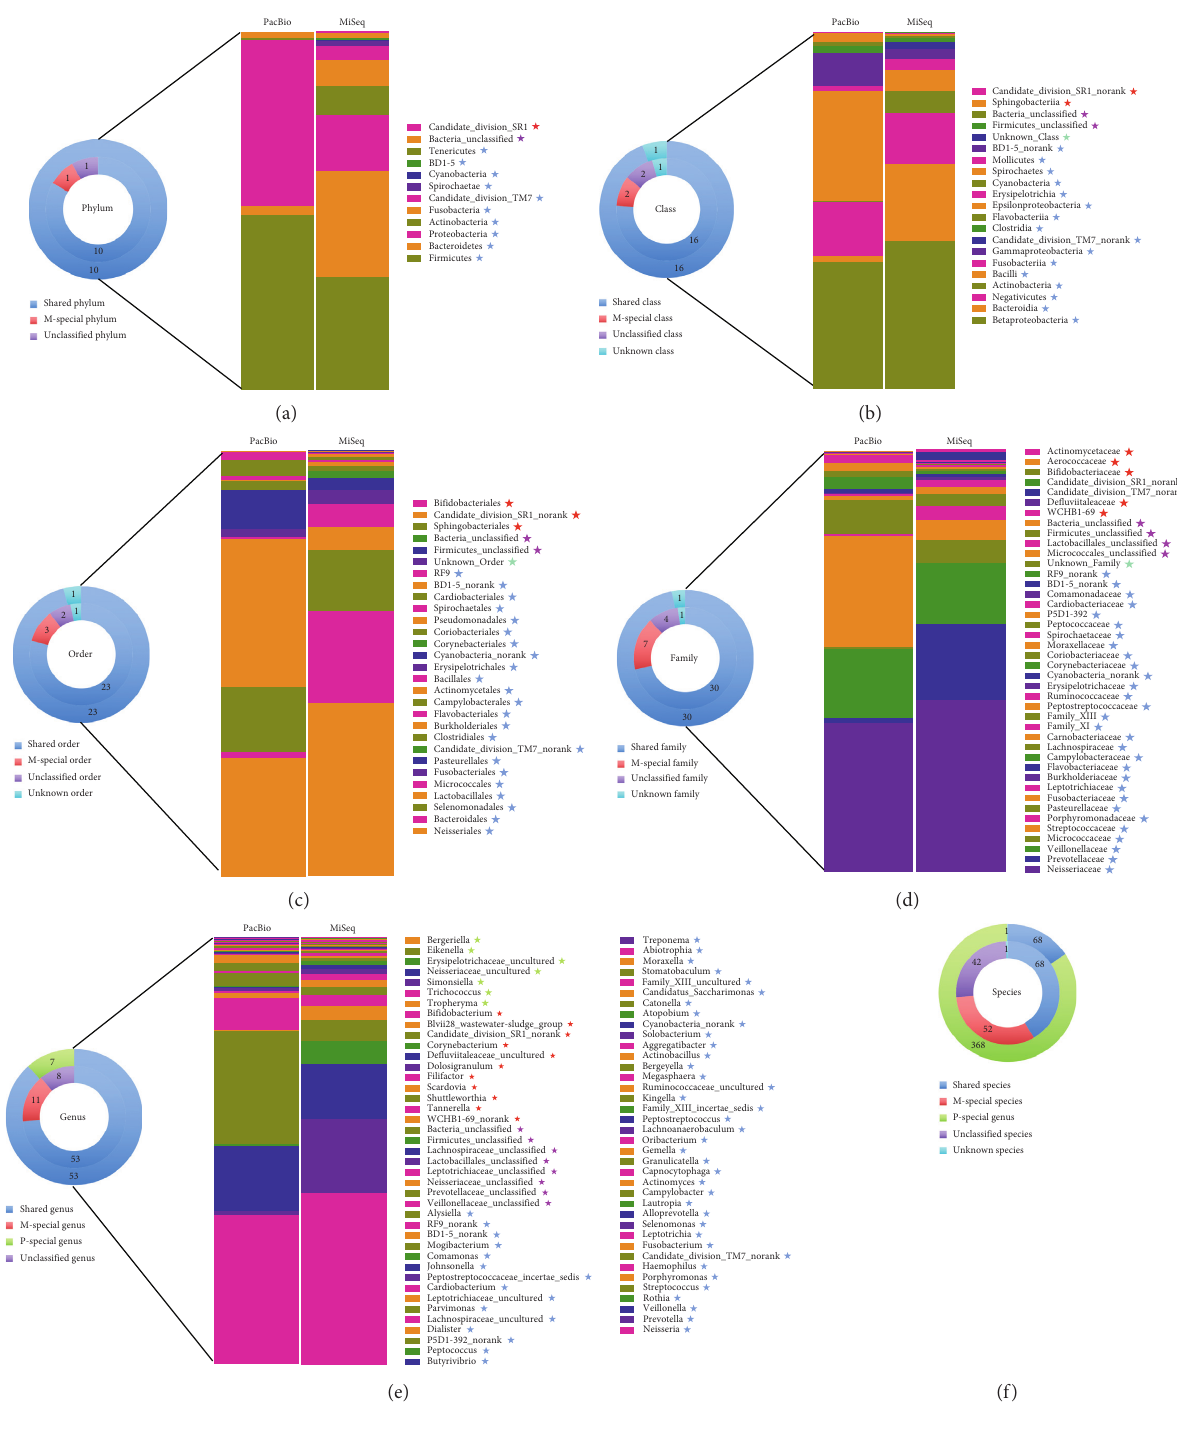
Figure 6: Community structures sequenced by PacBio and MiSeq platforms. represents the number of organisms shared by the two platforms and the detail taxonomy information was shown on the right bar chart. The star of the same color represents the names of the shared organism. represents the number of organisms generated only by MiSeq platforms and the detail taxonomy information was shown on the right bar chart. The star of the same color represents the names of the organism only generated by MiSeq. represents the number of unclassified organism and the detail taxonomy information was shown on the right bar chart. The star of the same color represents the names of the unclassified organism. represents the number of unknown organism and the detail taxonomy information was shown on the right bar chart. The star of the same color represents the names of the unknown organism. represents the number of organisms generated only by PacBio platforms and the detail taxonomy information was shown on the right bar chart. The star of the same color represents the names of the organism only generated by PacBio. (a–f) represents phylum, class, order, family, genus and species level,